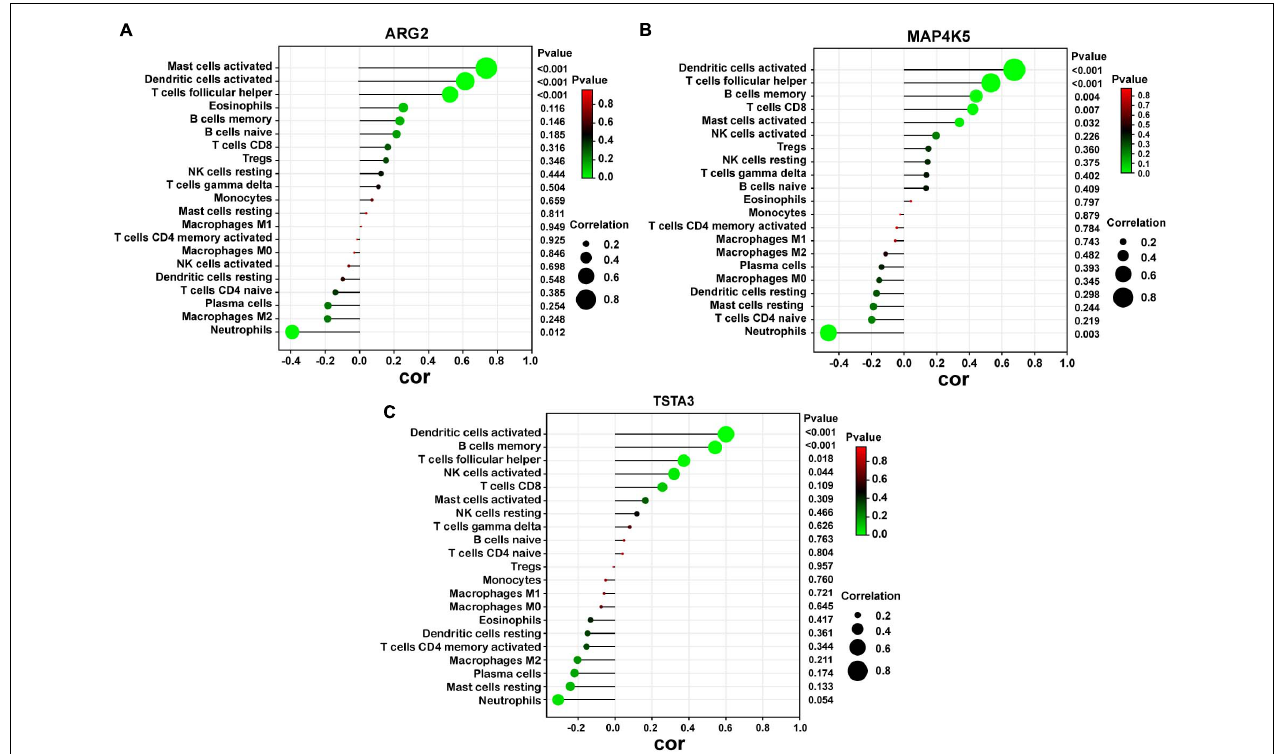
FIGURE 8 | Correlation between diagnostic markers and infiltrating immune cells. (A) Correlation between ARG2 and infiltrating immune cells. (B) Correlation between MAP4K5 and infiltrating immune cells. (C) Correlation between TSTA3 and infiltrating immune cells. The size of the dots represents the strength of the correlation between genes and immune cells; the larger the dots, the stronger the correlation, and the smaller the dots, the weaker the correlation. The color of the dots represents the p -value, the greener the color, the lower the P -value, and the red the color, the larger the p -value. P < 0.05 was considered statistically significant.